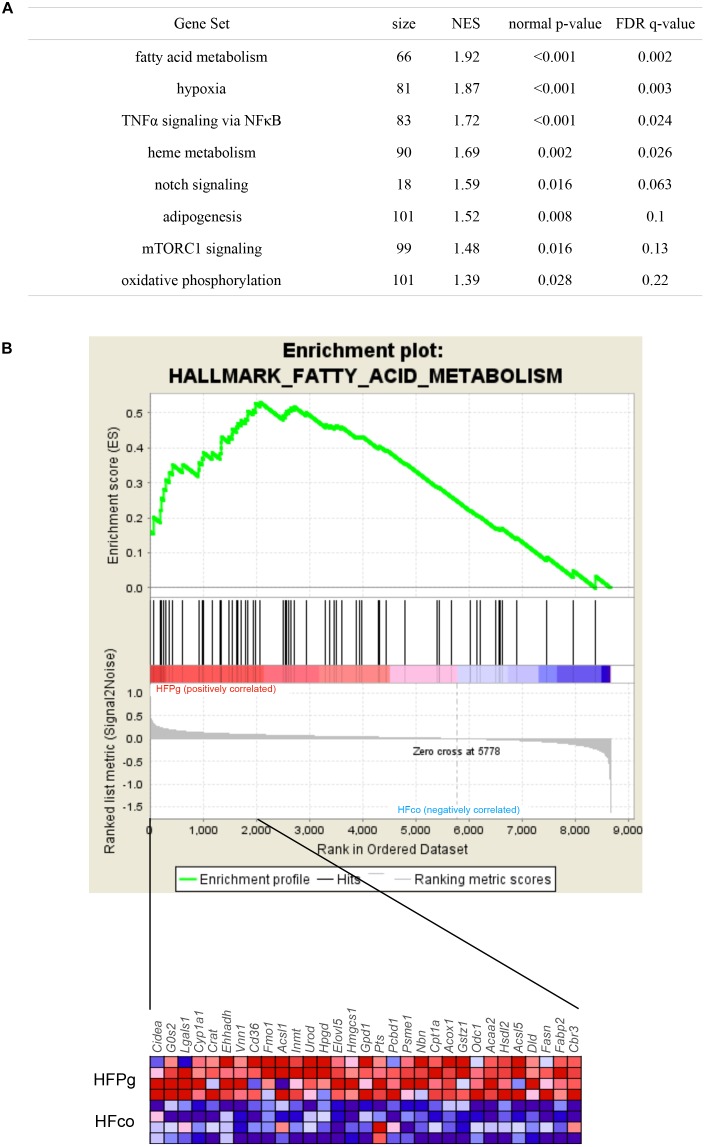
GSEA with hallmark gene sets enriched in HFPg mice compared to HFco mice (n = 4). (A) Gene sets showing FDR q < 0.25. NES: normalized enrichment score. (B) Gene set related to fatty acid metabolism. A heatmap provided illustrating gene expression levels for each gene in the core enrichment subset (blue: low, red: high).